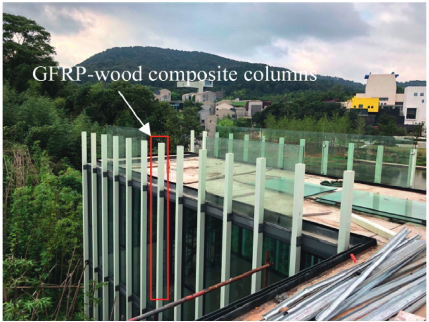
Figure 1: Nanjing Foshou Lake Hotel with GFRP-wood composite